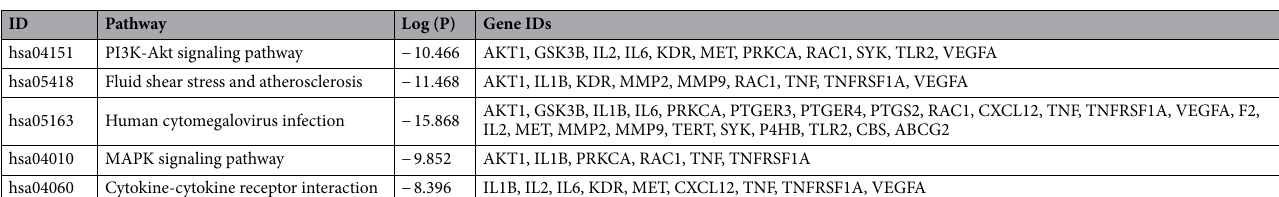
Table 5. Five common pathways associated with candidate targets according to enrichment analysis based on